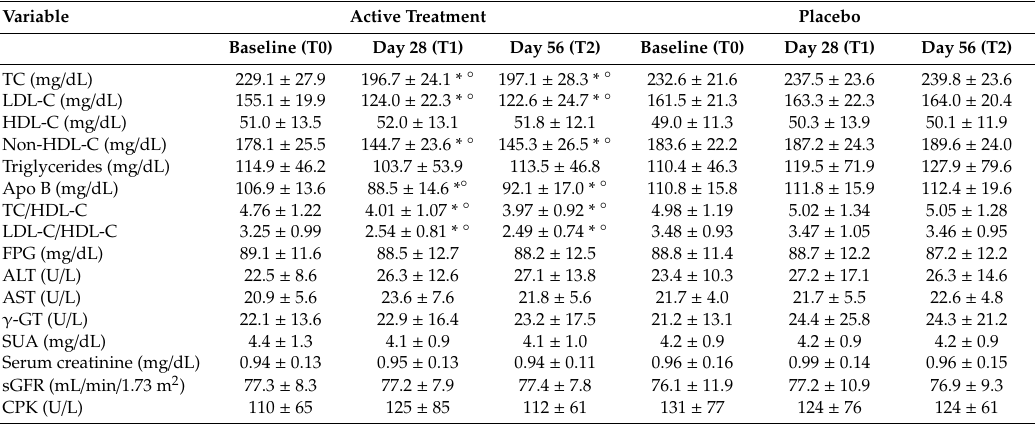
Table 2. Laboratory parameter changes during the study (values reported as mean ± standard deviation).